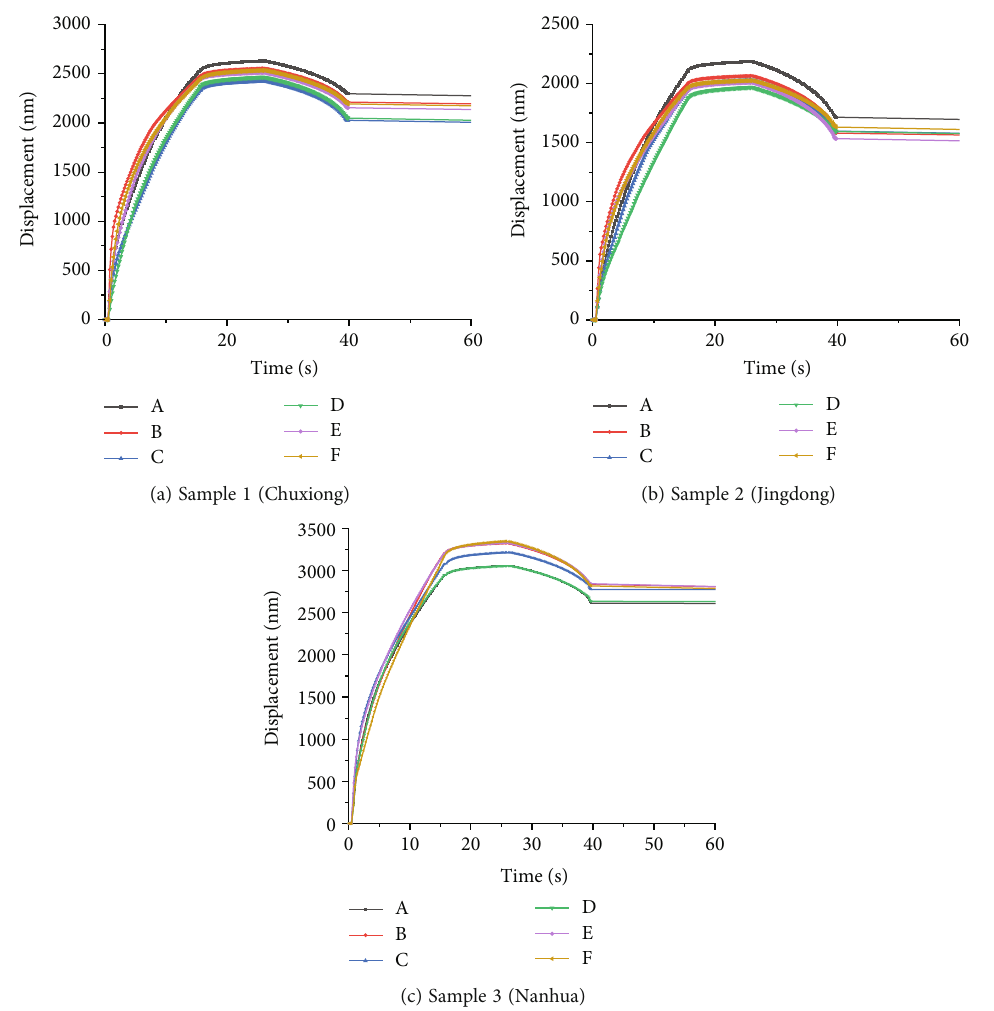
Figure 12: Nanoindentation displacement-time curves of Yunnan red-bed mudstone samples in three